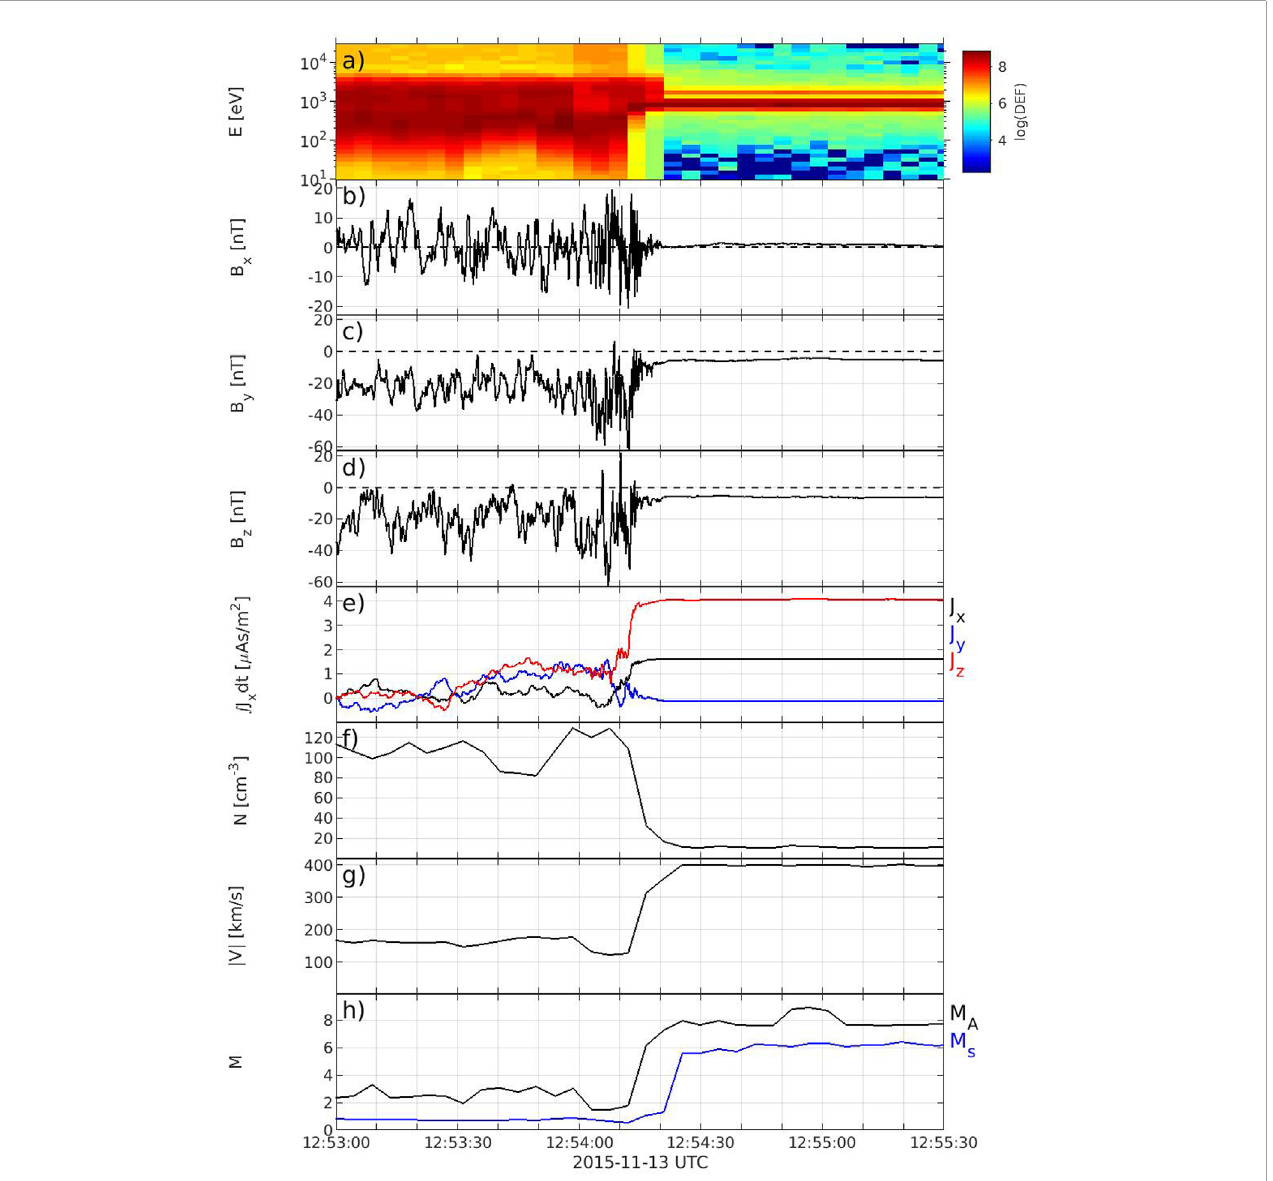
FIGURE 2 MMS observations of the bow shock. The spacecraft encountered the shock between 12:54:10 and 12:54:20 UT. (A) Ion energy-time spectrogram, (B–D) magnetic field components in GSE coordinates, (E) GSE components of J, each integrated with respect to time, (F) ion density, (G) the magnitude of the ion velocity, and (H) the Alvén (M A ) and magnetosonic (M s ) Mach numbers.